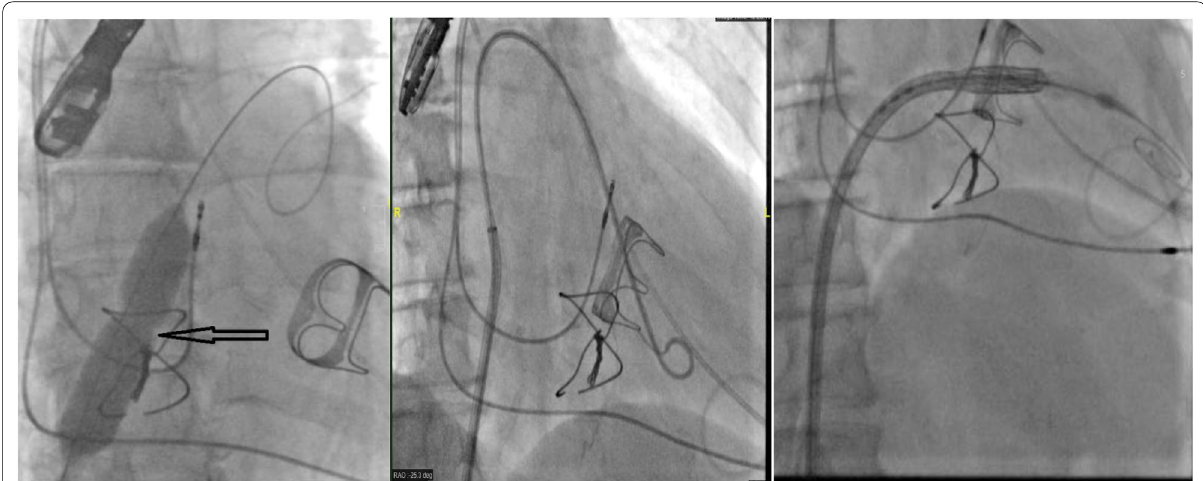
Fig. 4 important steps of the intervention: (1) dilatation of septum according with appropriate ballon size according to the device size and the anatomy of IAS, (2) the passage of pigtail into LV using steerable catheter or by advancing the catheter in the direction of LA roof to make a large loop in LA, (3) slowly withdrawal of the pigtail to get rid of this large loop in LA and then change to stiff preshaped wire